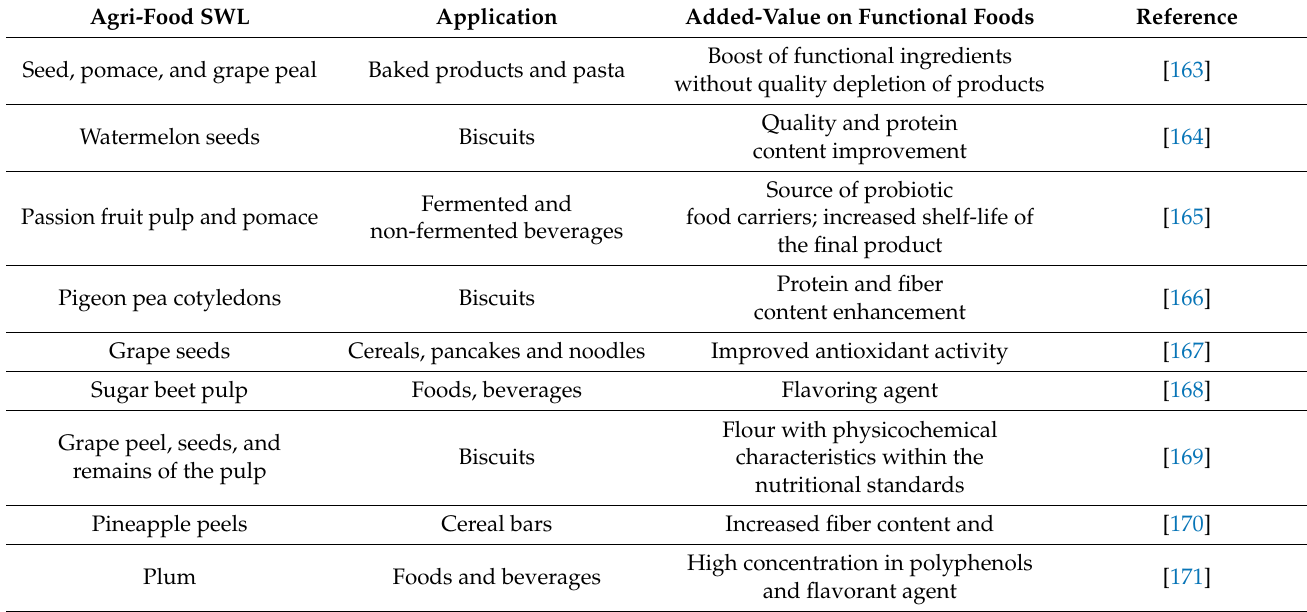
Table 7. Potential applications of agri-food SWL in the development of new value-added food